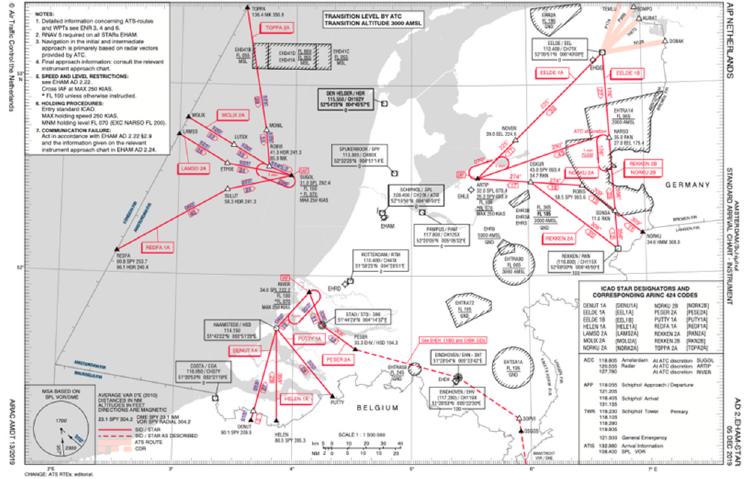
Figure 6. Standard arrival chart at Schiphol Airport. Source [24].